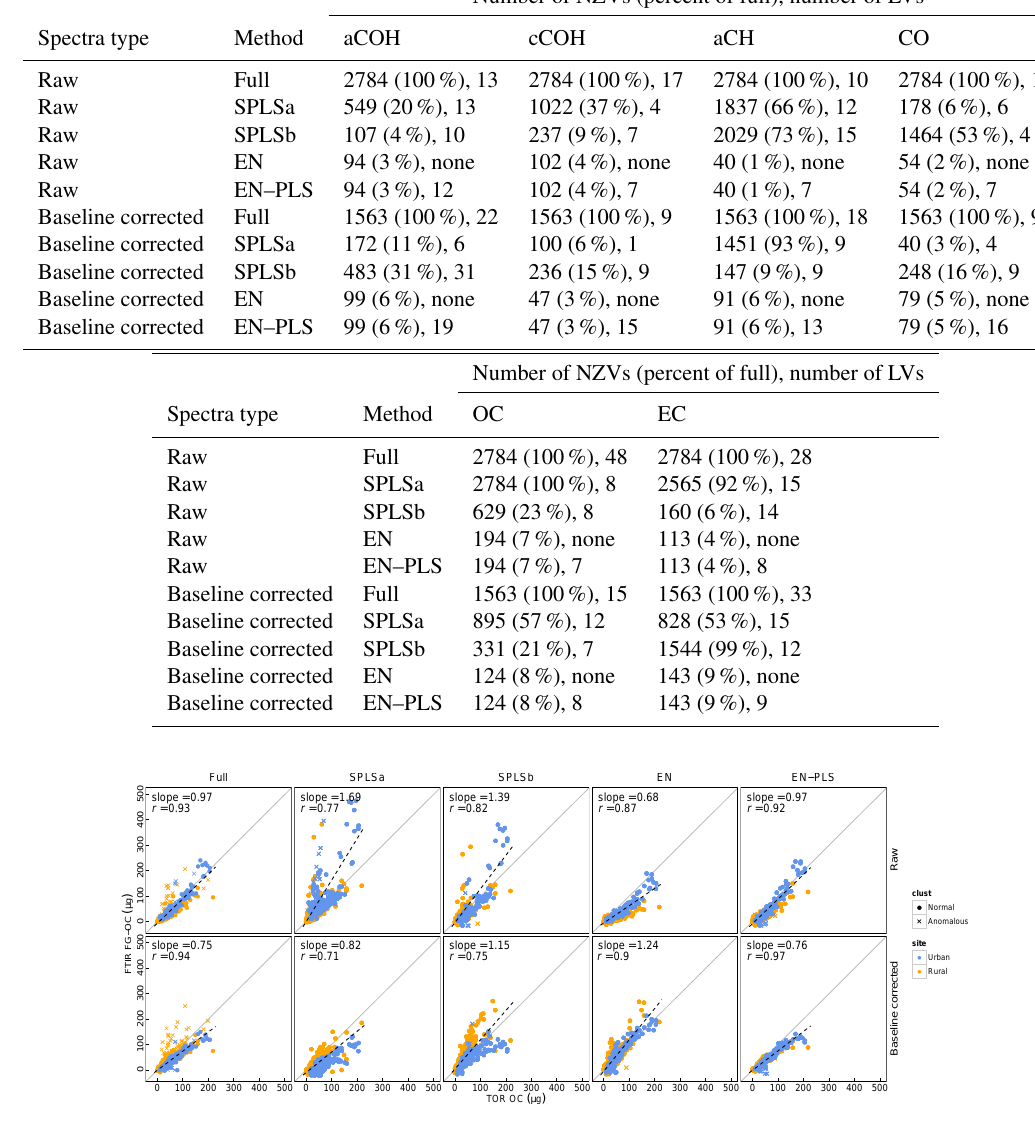
Table 1. Number of wavenumbers and LVs selected for final models. Spectra type